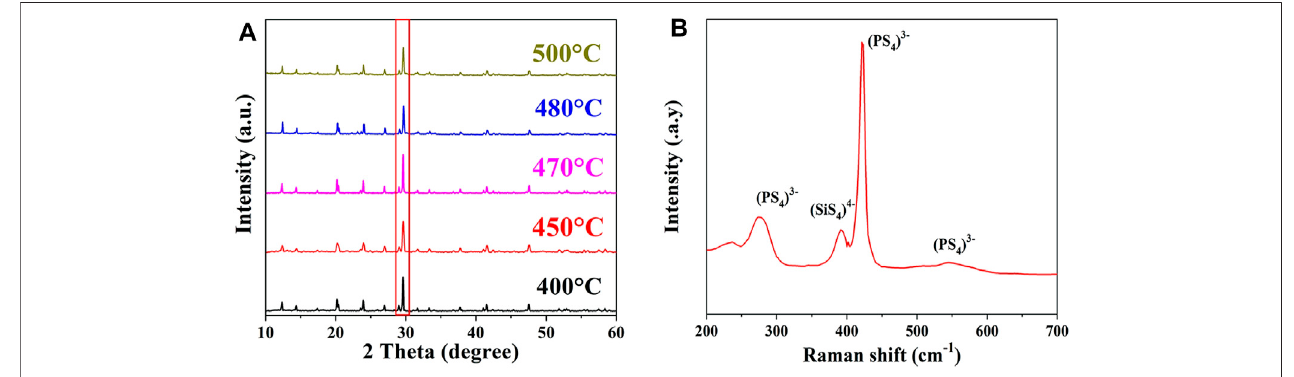
Figure 1B . The peaks at 275, 420, 550, and 575 cm − 1 are attributed to the characteristic signals of PS 43 − , whereas the peak at 390 cm − 1 comes from the stretching vibration of Si-S − bond in SiS 44- (Pradel and Ribes, 1989). The above results Li 10.35 Si 1.35 P 1.65 S 12